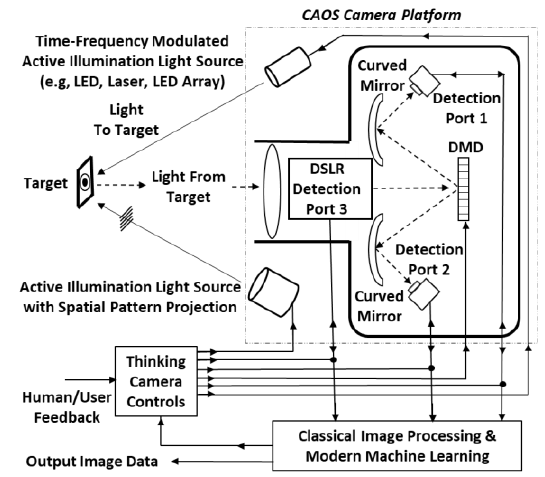
Figure 1 Thinking Camera Design empowered by the CAOS Camera